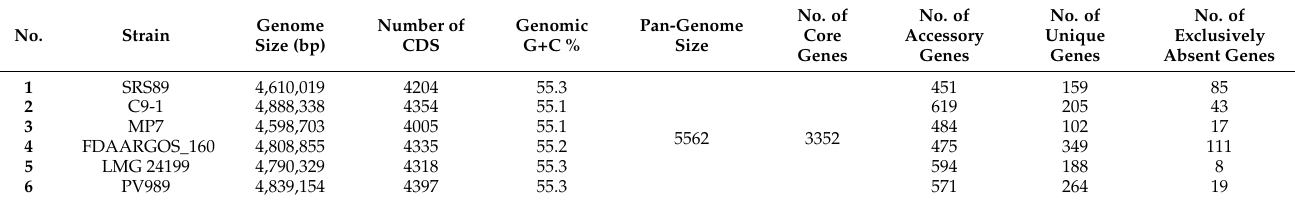
and metabolism, and carbohydrate transport and metabolism (Figure 3A), with a significant number of genes related to COG involved in membrane transport (Figure 3B).